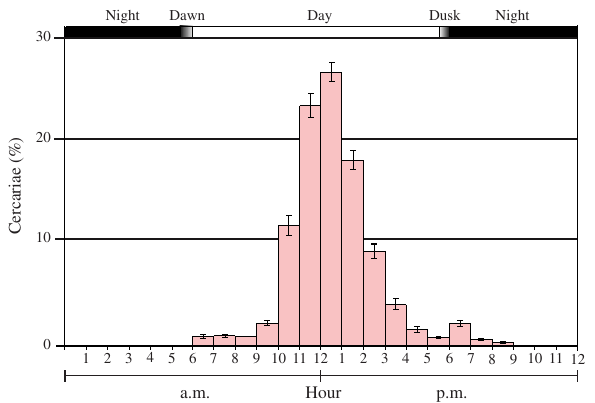
Figure 1. Average percentage of cercariae of Schistosoma haemat- obium (Libreville, Gabon) emitted every hour from B. globosus (Benin), each exposed to five miracidia. Bars represent standard